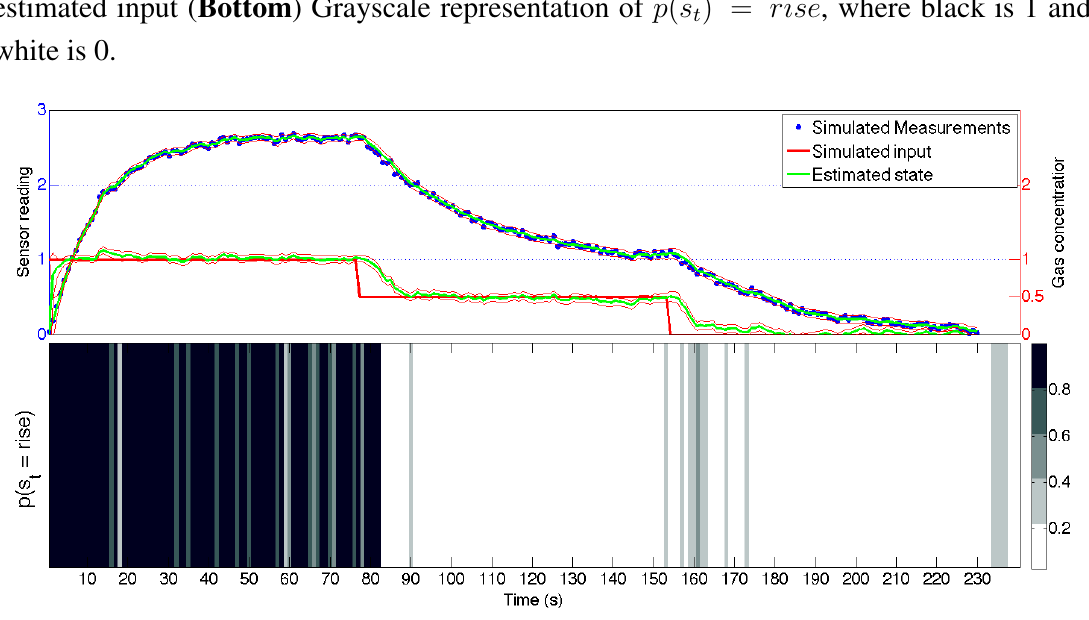
) = rise , where black is 1 and t